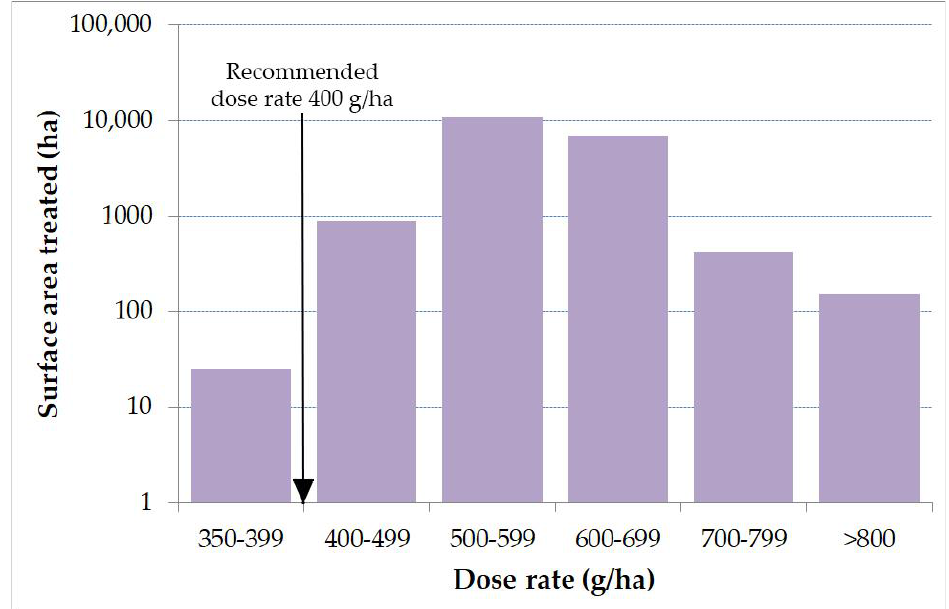
Figure 3. Dose rates of fenitrothion (g a.i./ha) in Kenya, January–April 2021, after 111 aerial treat- ments on 19,222 ha. The recommended dose rate is 400 g/ha. Data from the FAO SWARMS, detailed by FAO field operations officer